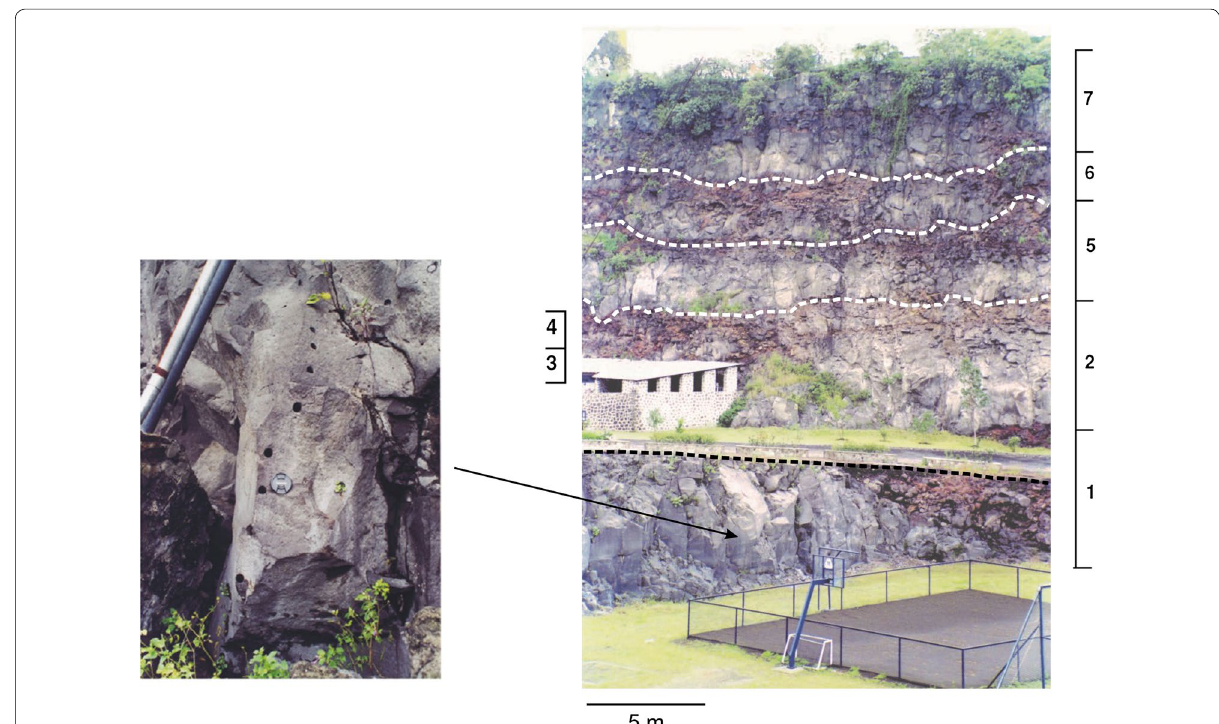
Fig. 2 Right: view of the 7 flows exposed at BCU quarry (adopted from Alva‑Valdivia 2005). Left: a closer view of the paleomagnetic